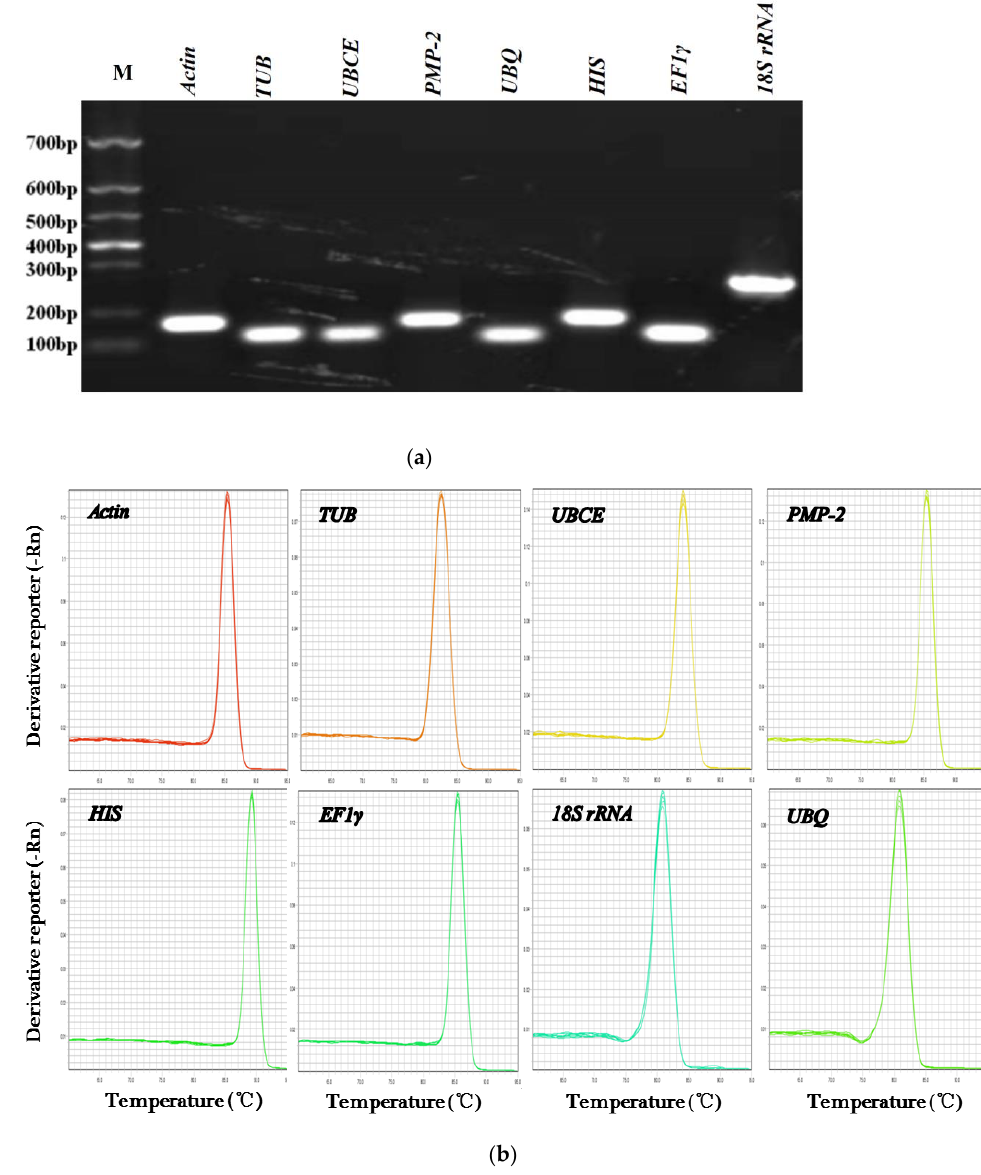
Figure 1. Amplification specificity of primers in RT-PCR and qRT-PCR. ( a ) Single amplicon of the desired size for each candidate reference gene (M represents marker) visualized on a 2% agarose gel and ( b ) melting curves of the eight candidate reference genes.